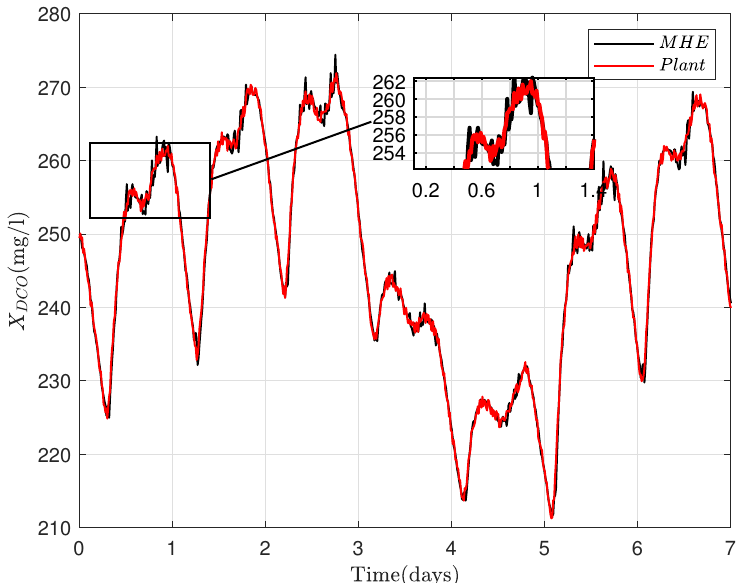
Figure 3. MHE estimate of oxygen demand concentration ( X COD ) for 7 days.